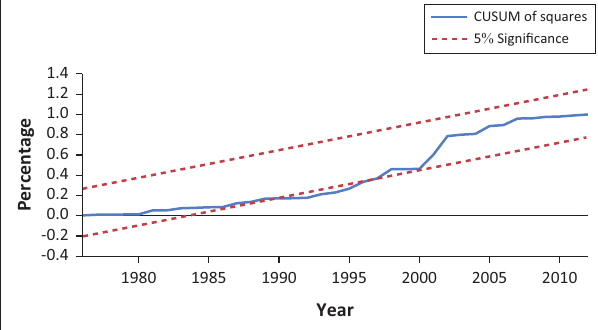
FIGURE 2: Cumulative sum of square test, 1908–2012.